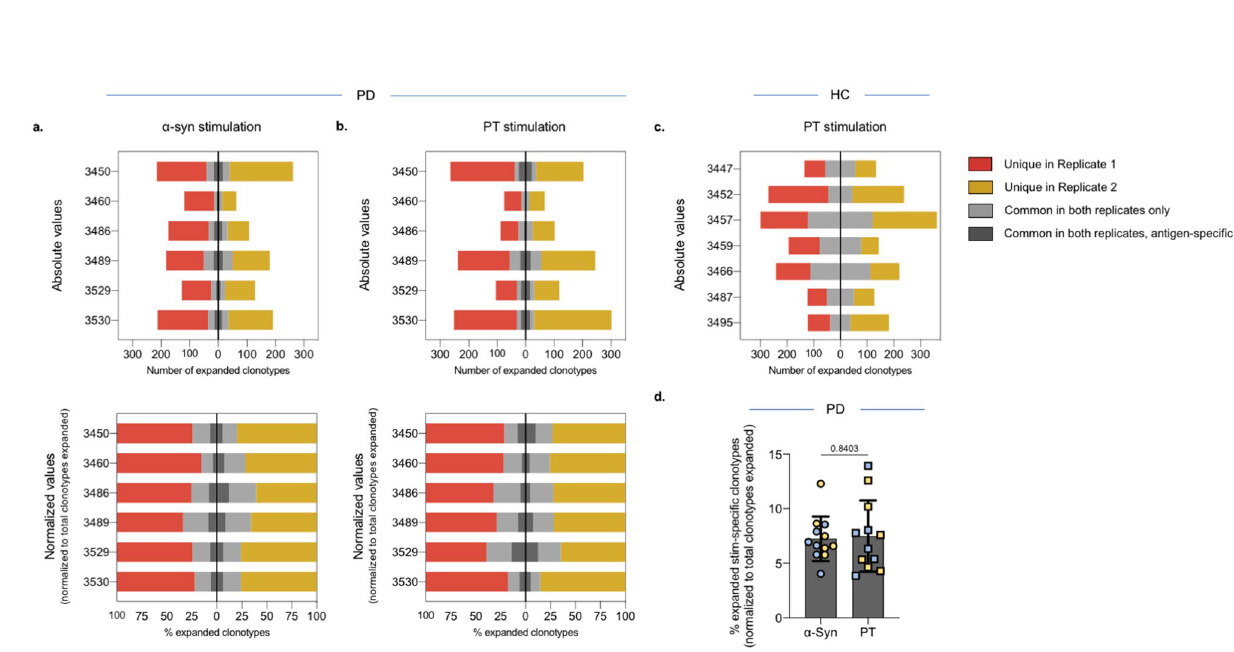
Figure 3. Similar numbers of expanded clonotypes in response to α-syn and PT stimulation. The number of expanded clonotypes in α-syn- and PT-stimulated PD ( a , b ) and HC ( c ) samples. For PD both absolute numbers (top) and normalized against total number of clonotypes in each replicate (bottom) is shown. Red indicates clonotypes that are unique in replicate 1, yellow indicates clonotypes that are unique in replicate 2. Grey indicates clonotypes that are common between the two replicates (− log 2 OR > 1 and FDR p val < 0.05) and dark grey indicates antigen-specific clonotypes, i.e., number and proportion of clonotypes that expanded only in each antigen-stimulated culture excluding clonotypes that expanded irrespective of stimuli. d Percentage of α-syn- and PT specific clonotypes in PD (dark grey in bottom graphs). Yellow (replicate 1) and blue (replicate 2). Mean ± StDev is shown. Paired two-tailed t